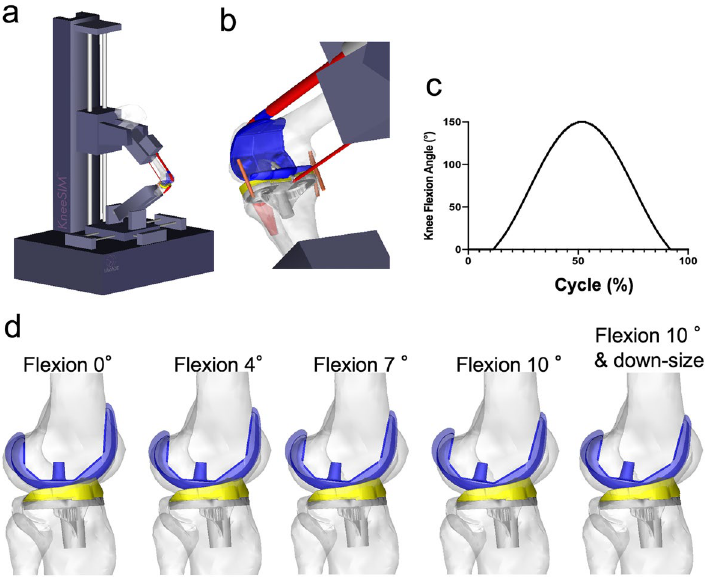
Figure 1. Computer-rendered images. ( a ) Overall picture of this study using Oxford-knee-rig. ( b ) Attachment of ligaments and boundary conditions with the Bi-Surface implant used in this study. ( c ) Simulation protocol and range of motion for deep knee bend. ( d ) Four computer simulation models with 0°, 4°, 7°, 10° flexion of the femoral component against distal femoral anatomical axis and implant down-size model with 10° component flexion in Bi-Surface